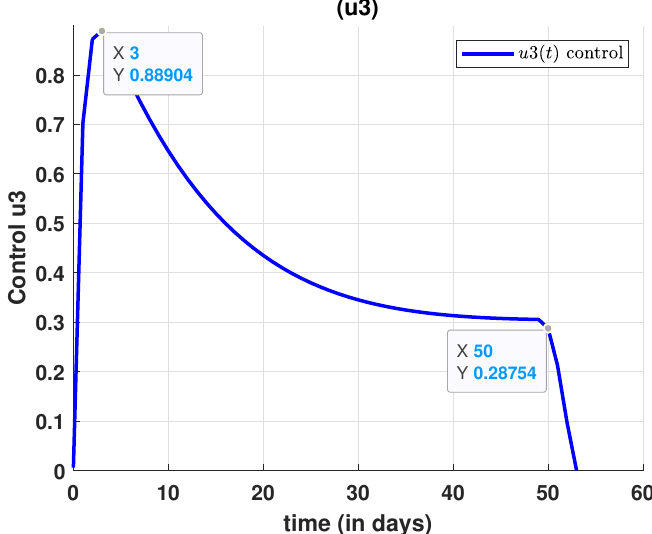
Figure 9. Evolutionary dynamics of the control u 3 ( t )